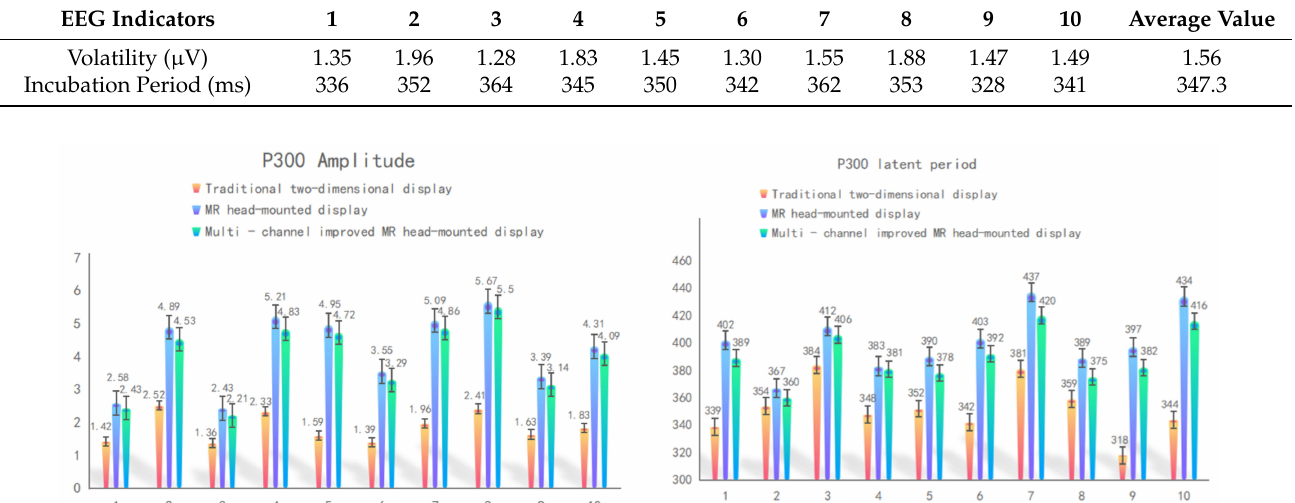
Table 9. MR display interaction system P300 EEG data after multi-channel improvement.